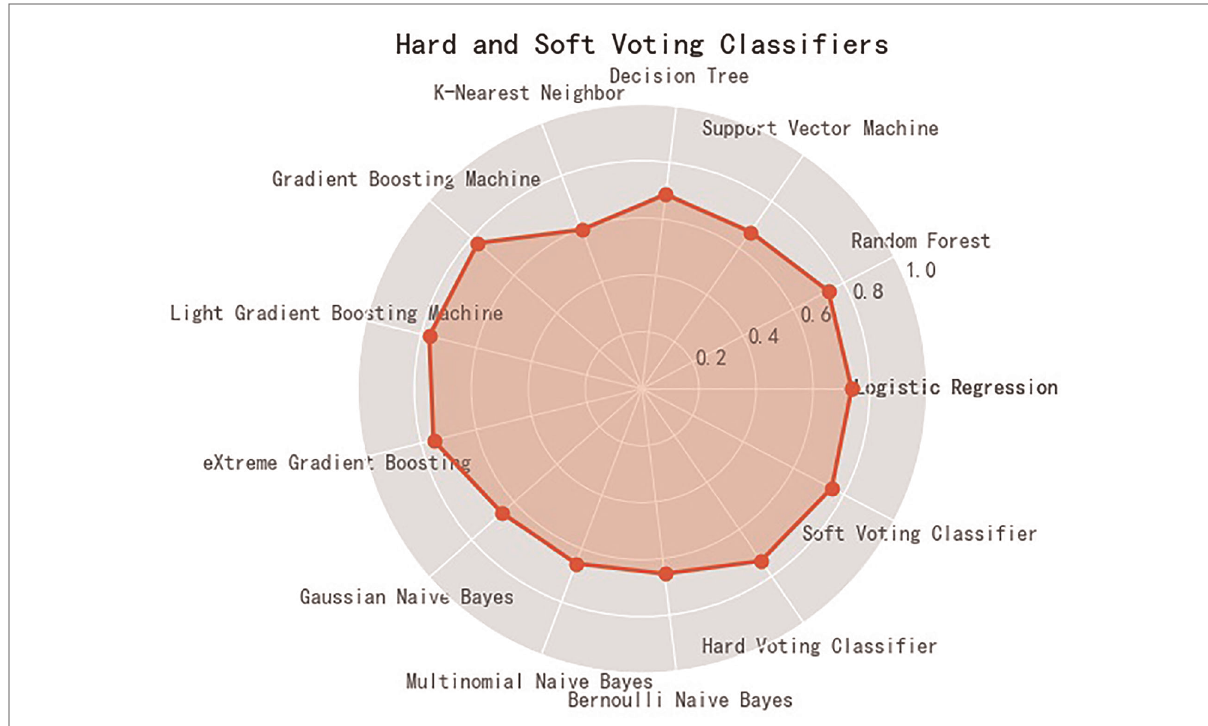
FIGURE 1 Accuracy of eleven machine learning models, along with hard-voting and soft-voting classi fi ers in predicting the risk of central obesity among school students. The solid red circle denotes the accuracy.